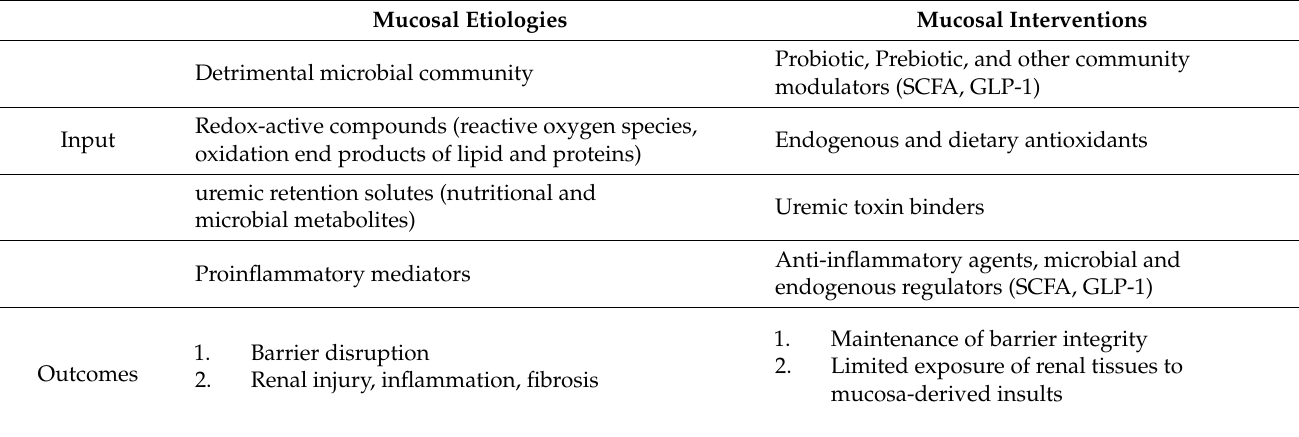
Table 1. Mucosal etiologies and interventions in response to PM exposure. Mucosal Etiologies Mucosal